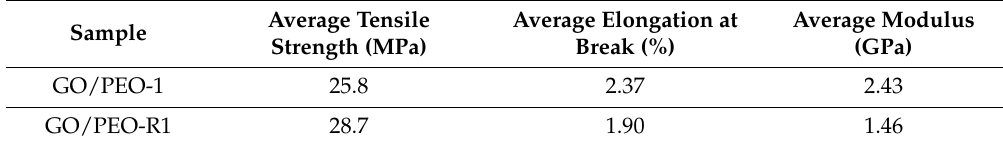
Figure 8. Stress–strain curves of ( a ) GO/PEO-1 and ( b ) GO/PEO-R1. Table 2. The tensile strength of the GO/PEO hybrid film.